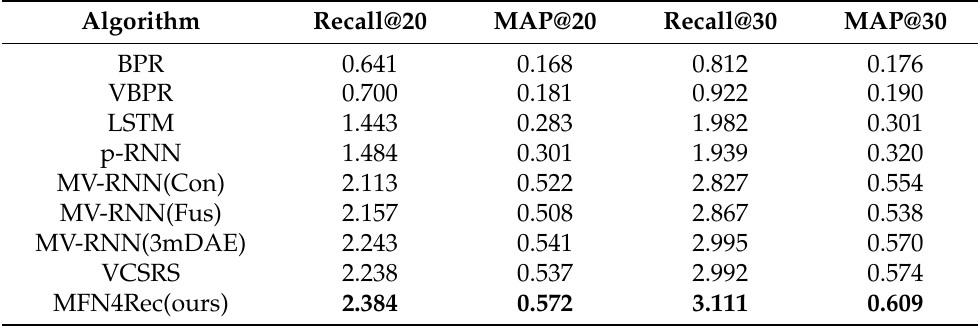
Table 3. The performance comparison with baseline algorithms on the Amazon Clothing dataset.